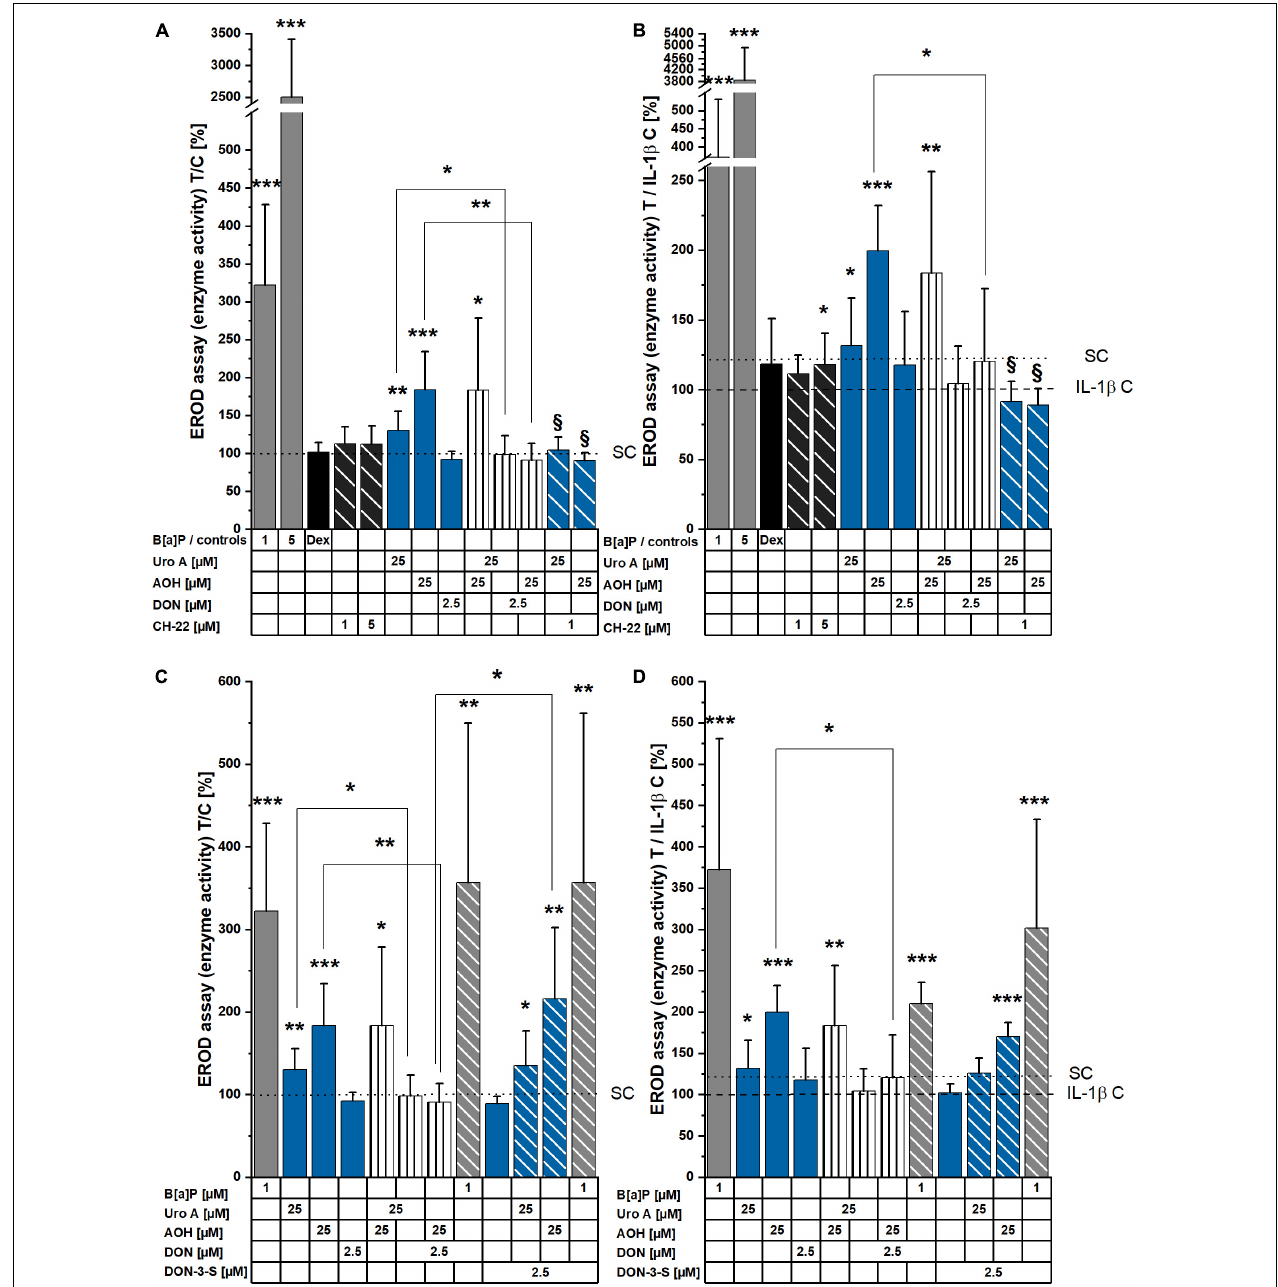
FIGURE 2 | 7-ethoxy-resorufin- O -deethylase (EROD) assay measurements showing induction of CYP1A1/1A2/1B1 enzyme activity. (A,B) Cell monolayers were incubated with compounds for 48 h, and (C,D) additionally stimulated with IL-1 β (25 ng/mL), 2 h into substance incubations. Enzyme activity (pmol resorufin/30 min/protein) was normalized to the respective control condition and is presented as T/C in%. Significant differences compared to the controls were calculated applying two-sample Students’ t -test and are shown as * p < 0.05, ** p < 0.01, and *** p < 0.001. § marks significant differences of combi incubations with CH-22 compared to the respective single compound ( p <